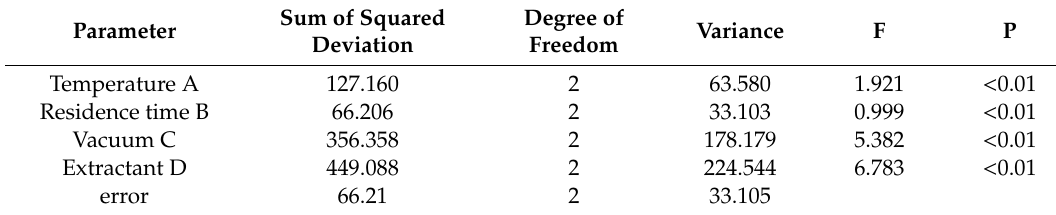
Table 5. Analysis of variance of orthogonal test results.